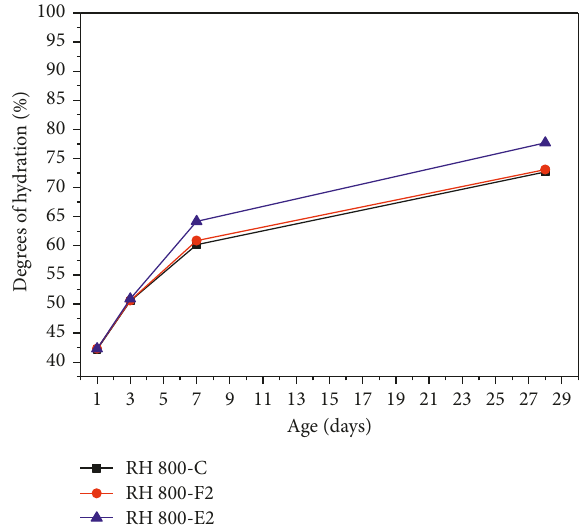
Figure 7: Degrees of hydration of the foam